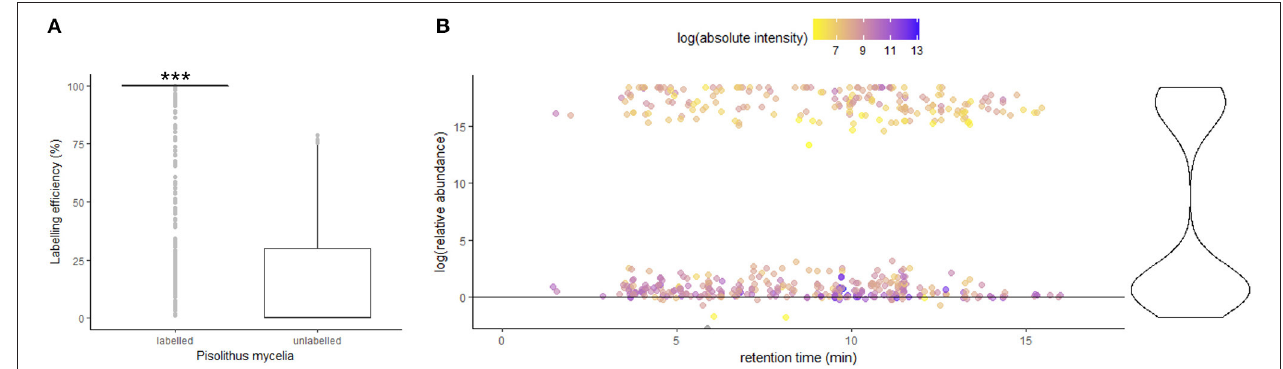
FIGURE 5 | Fungal signaling metabolites are detected in roots during pre-symbiotic interaction (A) Box plot depicting the 13 C-labeling efficiency of each compound detected in Pisolithus mycelia samples ( n = 2 per condition) in labeled setup compared with unlabeled setup (negative control). Labeling efficiency = intensity of 13 C isotope-labeled compound/(intensity of 13 C -labeled compound + unlabeled compound) × 100. The asterisks (***) indicate a highly significant difference in terms of labeling efficiency in labeled condition in comparison to unlabeled control ( p < 2.2e − 16 with paired t -test). ( B , left) Scatter plot showing the abundance of 13 C-labeled compounds in Pisolithus -interacting root tips in labeled setup in relation to unlabeled setup, across the retention time span of LC-MS ESI + mode metabolite profiling. The color of the points showing the absolute intensity of the compound peak detected by the LC-MS. An unlabeled or mis-detected labeled metabolite would have a log (relative abundance) ≤ 0. ( B , right) The violin plot demonstrates the distribution of 13 C-labeled compounds with different relative abundance.